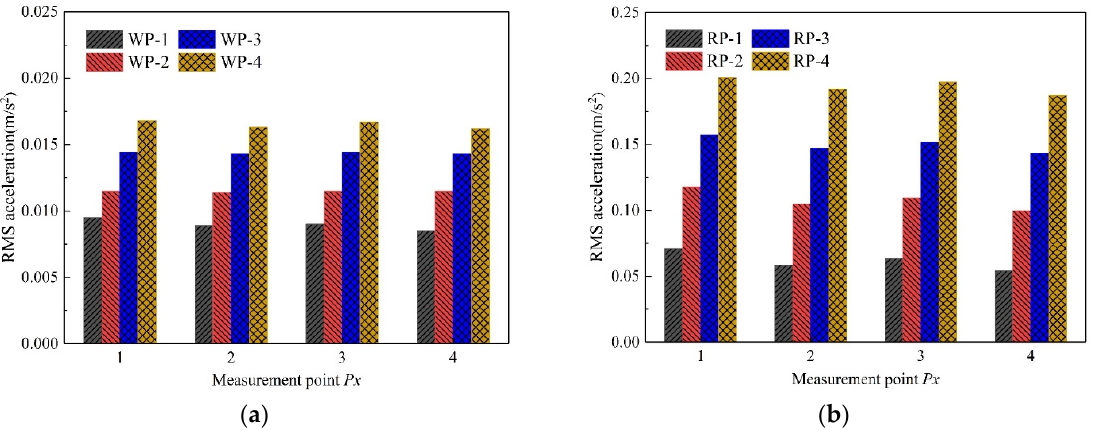
Figure 6. Field tests of human-induced vibration: ( a ) single pedestrian walking in place; ( b ) 40 pedestrians walking in place.